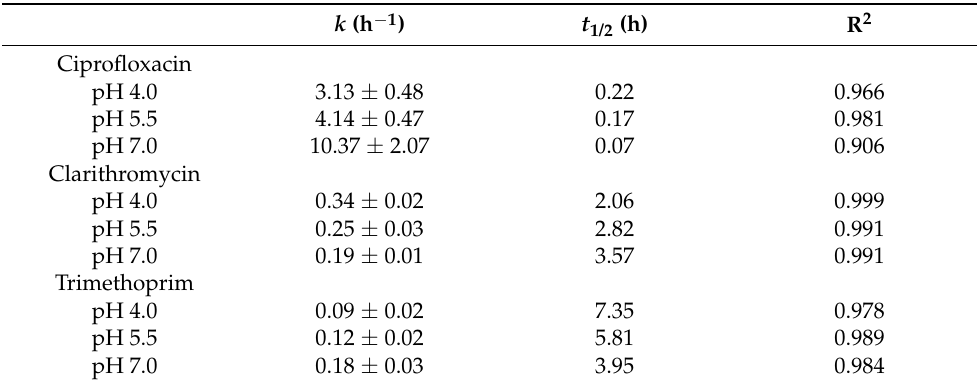
Table 2. Half-life ( t 1/2 ) and degradation kinetic constants ( k ) values for each antibiotic at the three pH tested. Average values (n = 3) ± standard error.